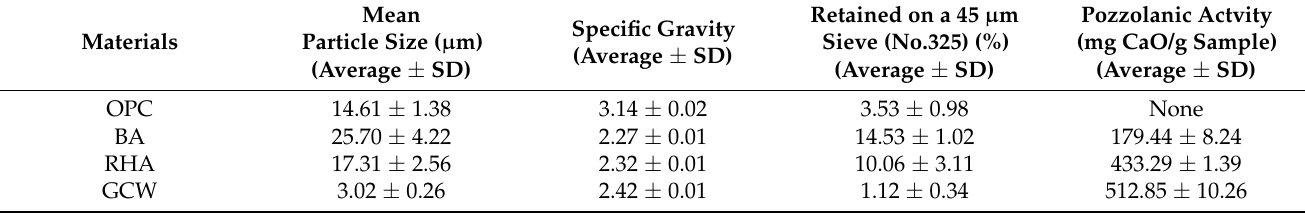
Table 1. Physical properties and pozzolanic activity of the materials.